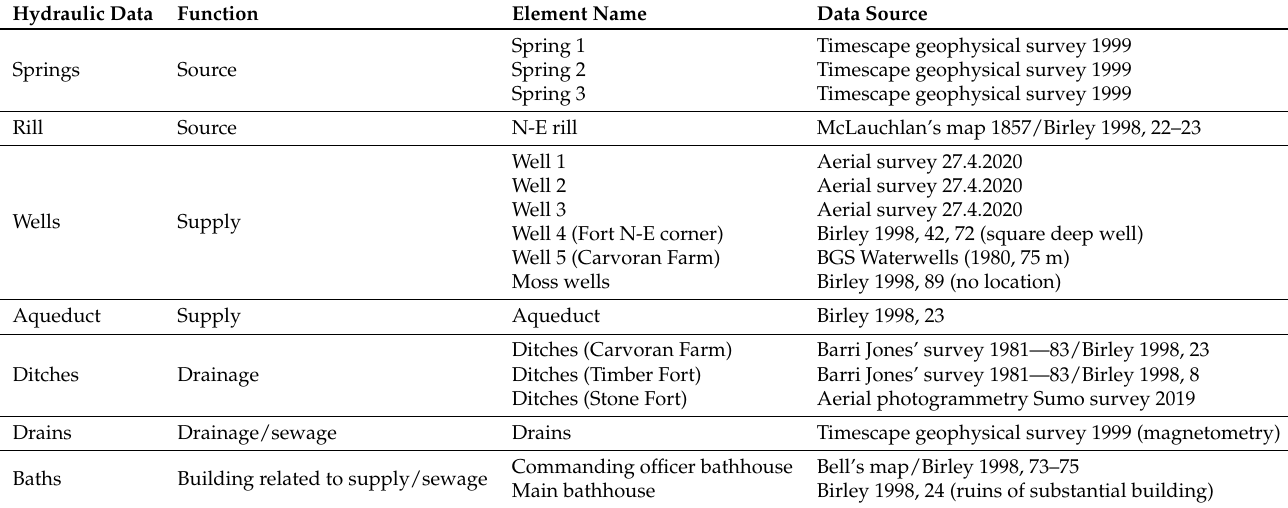
Table 2. List of sources used to define the hydraulic systems elements shown on the map in Figure